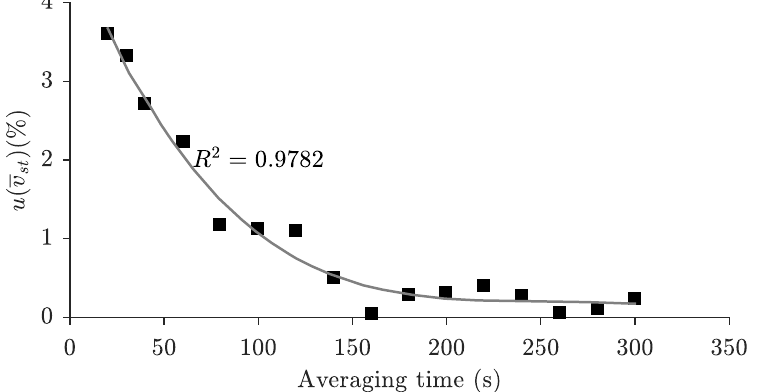
Figure 3. Variation of the sampling time standard uncertainty for [10]